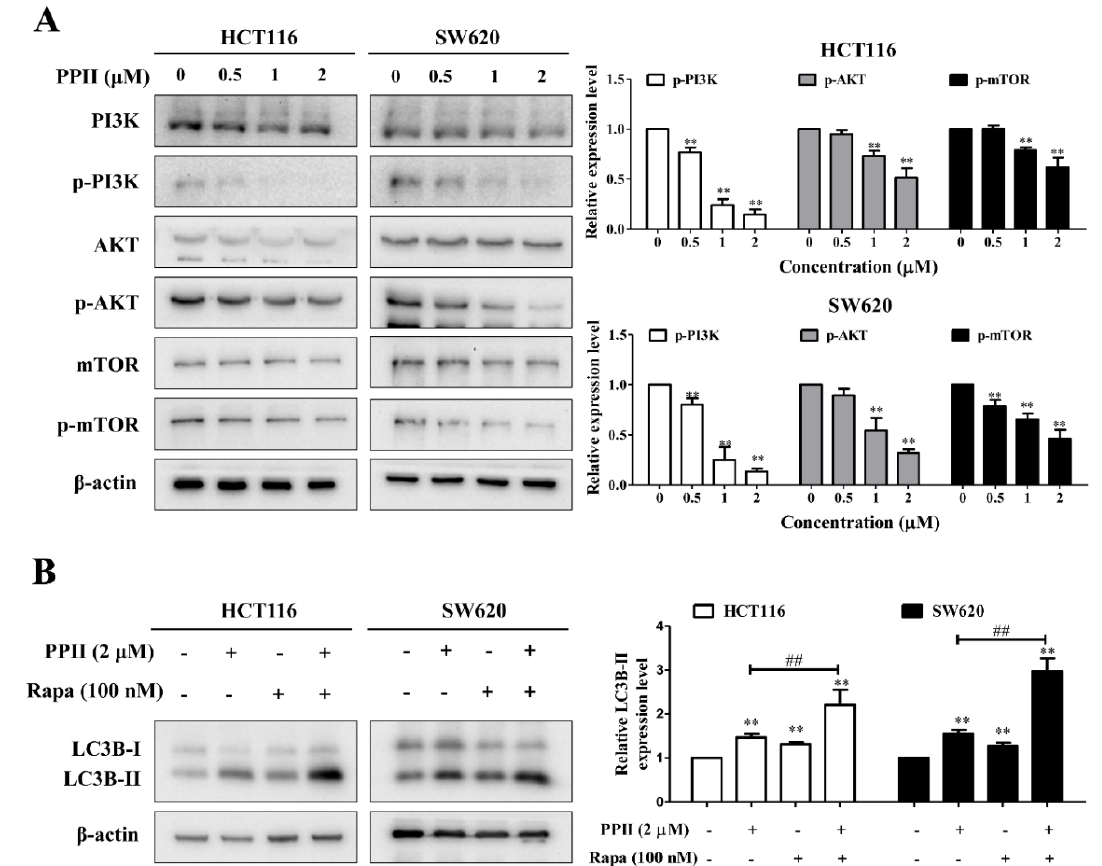
Figure 5. The inhibition of the PI3K/AKT/mTOR signaling pathway is required for PPII-mediated autophagy initiation in CRC cells. ( A ) PPII suppressed the activities of PI3K, AKT, and mTOR in CRC cells. The cells were treated with various concentrations of PPII for 24 h. The protein levels were examined using Western blotting. β -actin was used as a loading control. ( B ) The protein level of LC3B − II in CRC cells exposed to PPII, with or without rapa (100 nm), for 24 h. the representative immunoblotting bands are presented in the left panels, and the quantitative results are shown in the right panels. The data in the bar charts are the means ± SD of three independent experiments. ** p < 0.01 vs. vehicle control; ## p < 0.01.